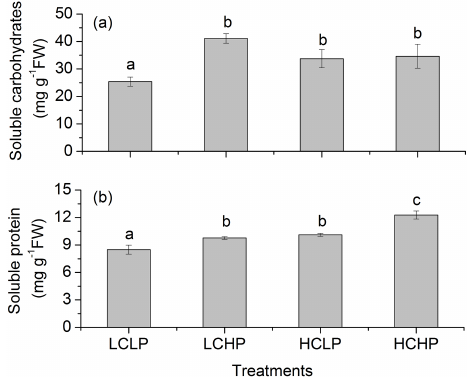
Figure 7. The contents of soluble carbohydrates (a) and protein (b) of S. muticum after being grown at different p CO 2 and P conditions for 13 days. Data are reported as means ± SD ( n = 3). LCLP is the low p CO 2 and low P condition, LCHP is the low p CO 2 and high P condition, HCLP is the high p CO 2 and low P condition, and HCHP is the high p CO 2 and high P condition. Different letters above the error bars indicate significant differences between treatments ( P < 0 . 05).